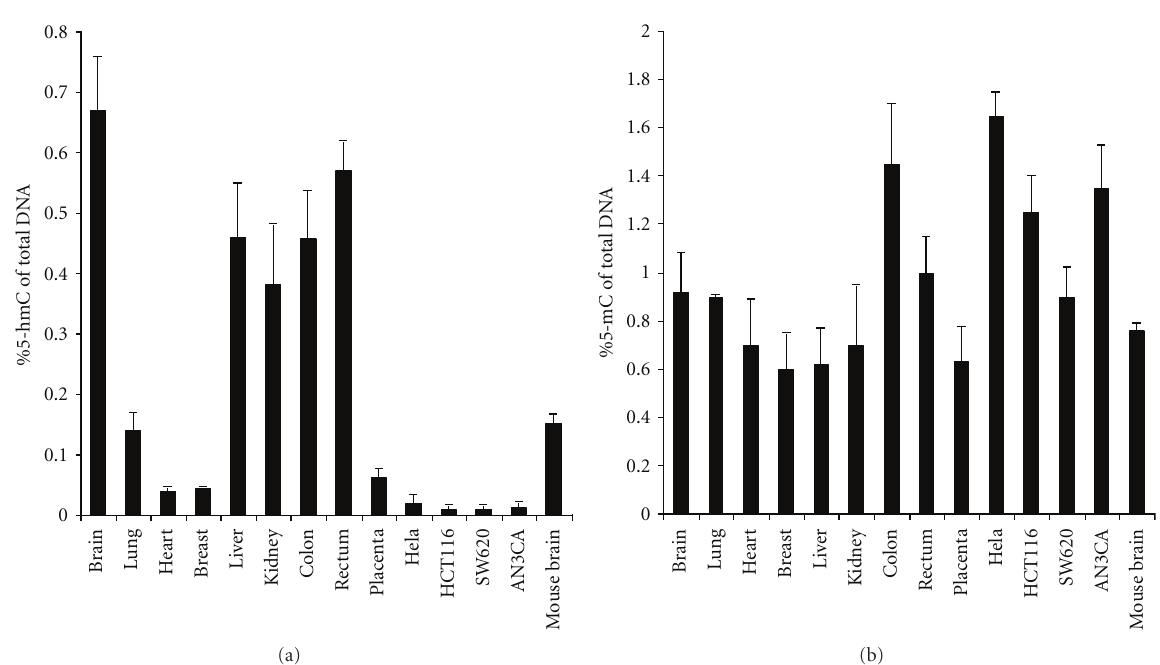
Figure 2: Quantification of 5-hmC and 5-mC in genomic DNA isolated from human tissues. (a) 5-hmC contents. The data are average values ± standard deviation from 3 di ff erent assays. (b) 5-mC contents. The data are average values ± standard deviation from 3 di ff erent